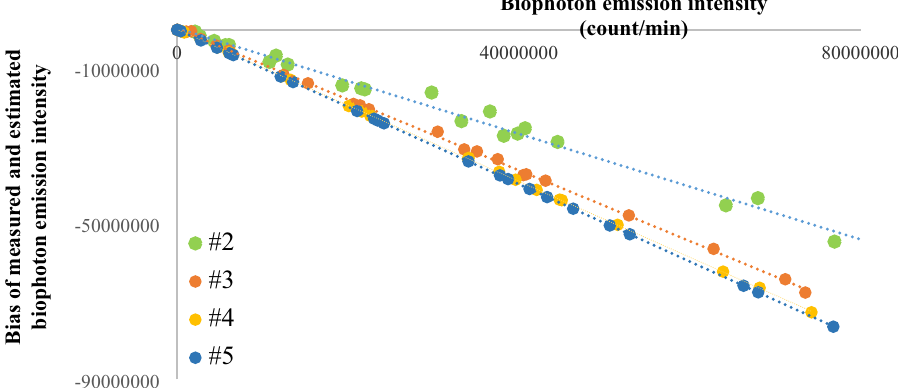
Figure 7. Scatterplot of measured biophoton emission intensity and the bias of measurement and estimation in all experimental groups in each time step on Leaf A. There is a systematic error that can be estimated by linear regression models.